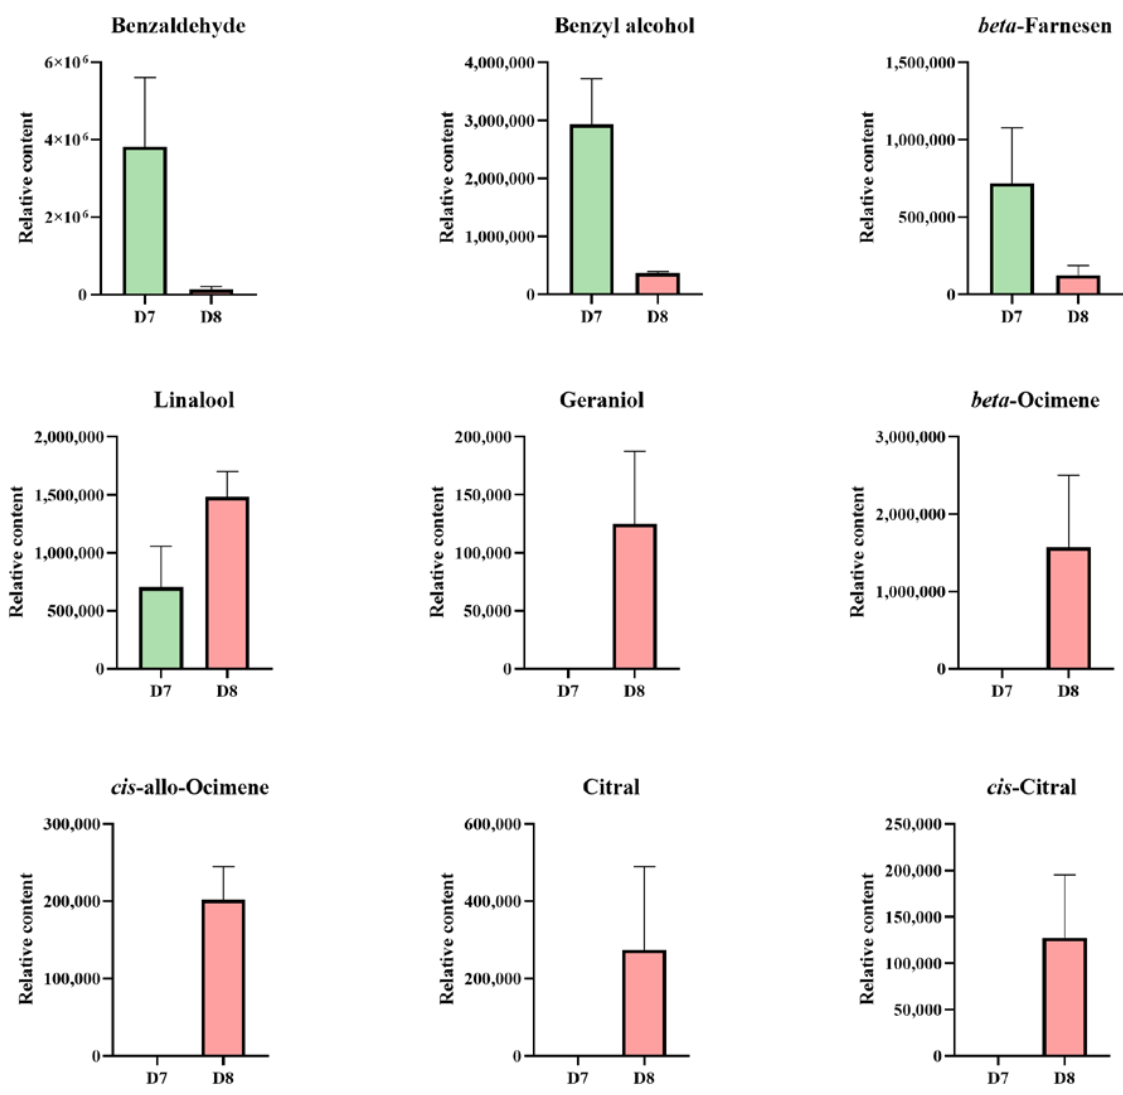
Figure 2. The relative contents of VOCs emitted by KOVA perianths during flowering. The relative content represents the result calculated by the external standard method based on data produced by GC. The data are the mean ± SD from three biological replicates.